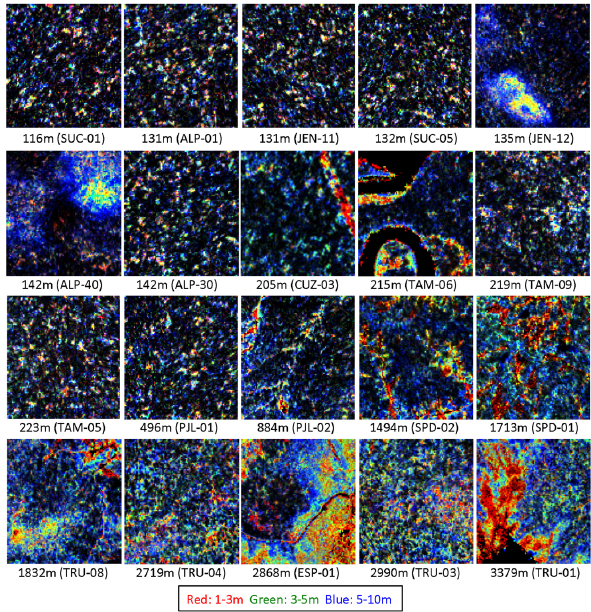
Fig. 5. Images showing understory plant cover (presence vs. ab- sence) in 1–3m (red), 3–5m (green), and 5–10m (blue) height classes. Images are arranged by elevation to match Figs. 1 and